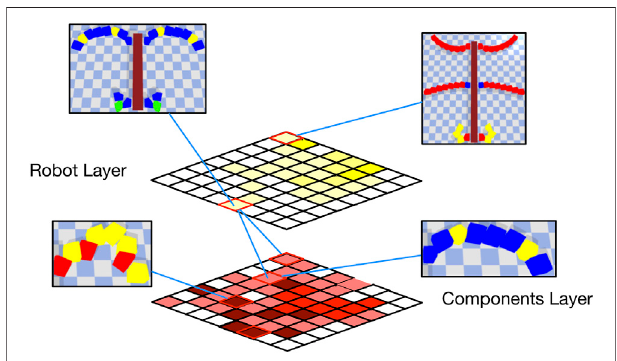
FIGURE 5 | A conceptual diagram for the MLE instantiation illustrating the robot and components layer.